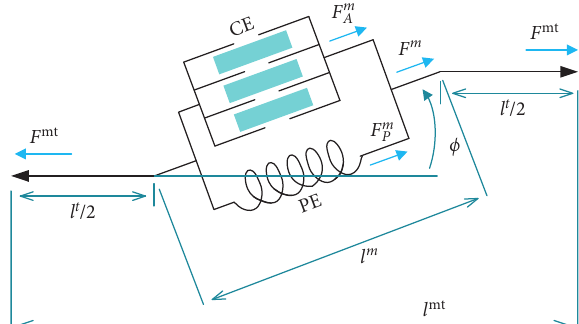
Figure 5: Hill-based muscle